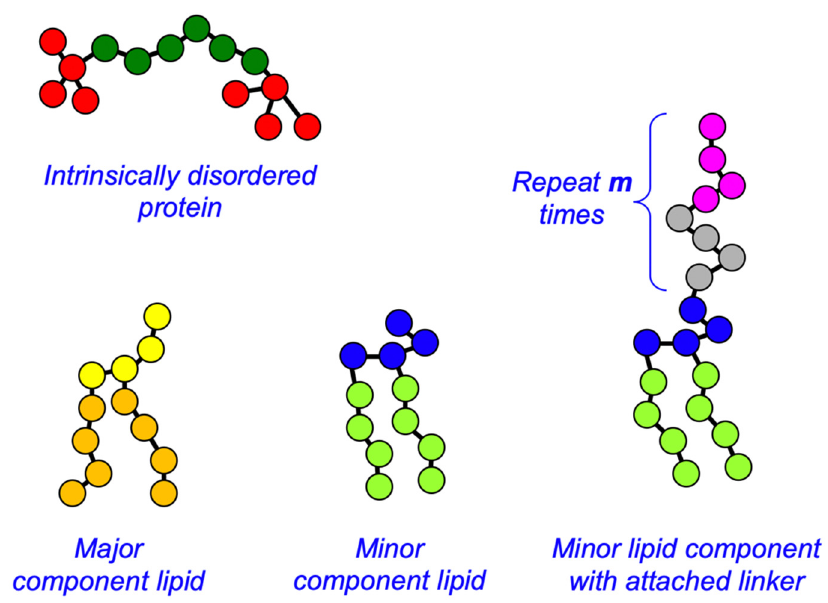
Figure 2. Cartoon of the molecular shape of the IDPs and lipid species. The conservative interactions for all bead types are given in Table 1. Note that the head beads and tail beads of the two lipid species are colored differently for clarity but are otherwise the same in the simulations. The number of linker elements can be varied, but is fixed at m = 8 for simplicity. The number of backbone beads in the IDPs is shown as six, but is varied as part of the investigation.